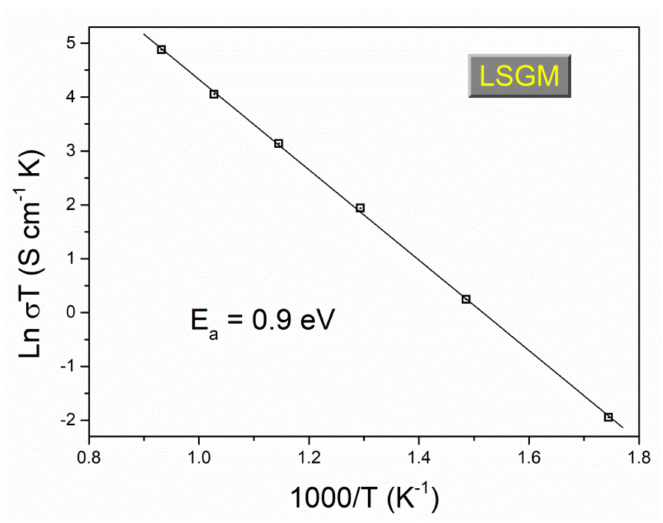
Figure 7. Activation energy obtained from the complex impedance spectrum. Table 2. Ionic conductivity at 800 ◦ C of LSGM samples prepared by various synthesis